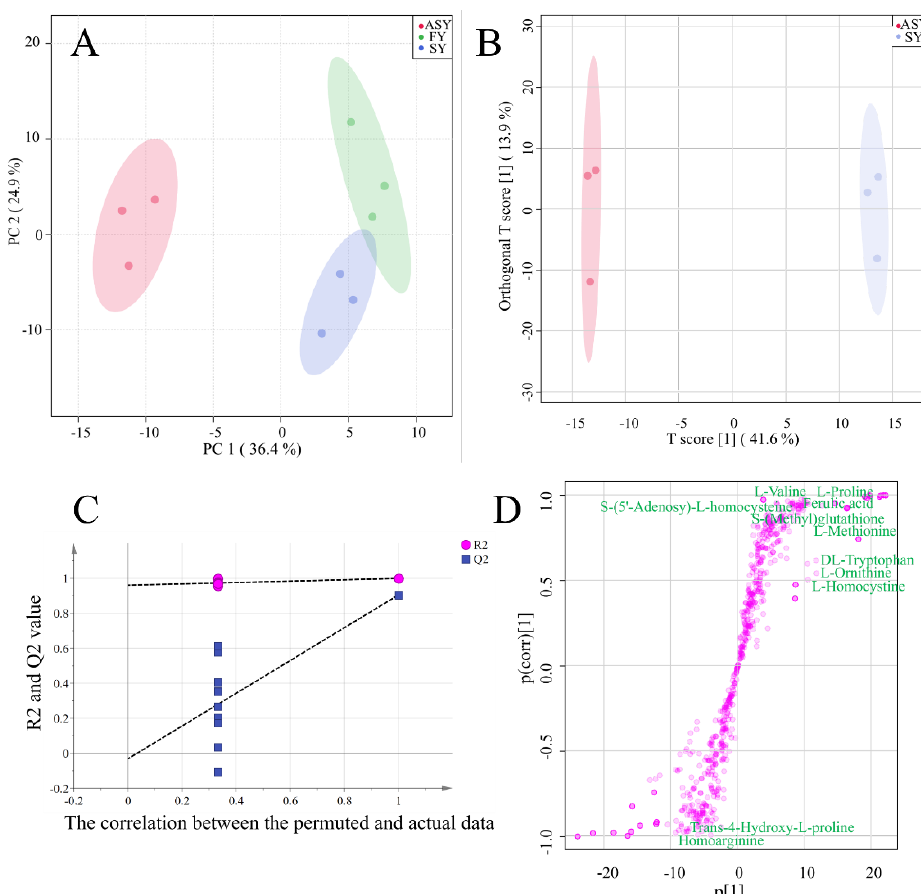
Figure 4. The results of unsupervised recognition and supervised recognition of metabolic data of F. cirrhosa . ( A ) Principal component analysis among three phenotypes; ( B ) score plot of OPLS-DA between ASY and SY; ( C ) the results of 200 times permutation test of OPLS-DA; ( D ) S-plot of OPLS-DA. FY: four-year samples, SY: six-year samples, ASY: aberrant six-year samples.